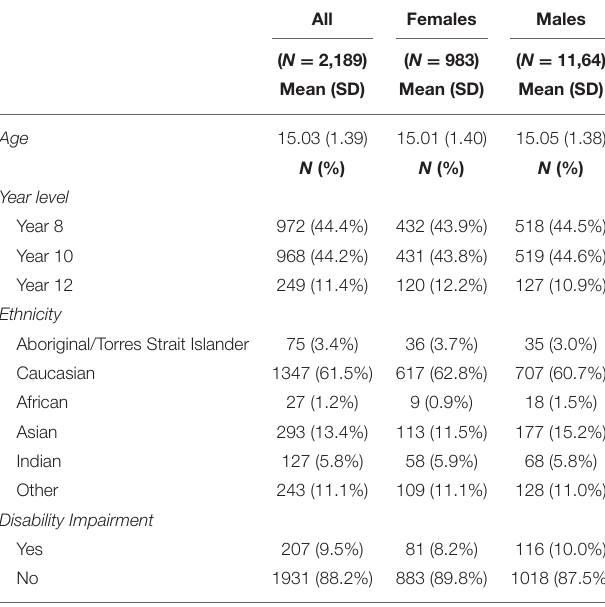
TABLE 1 | Summary of participant characteristics for phase 1.